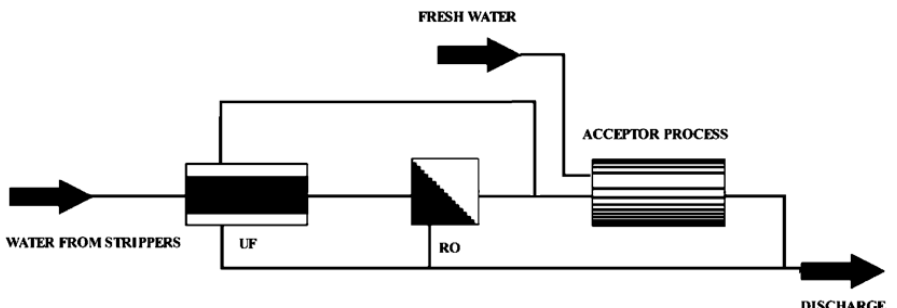
Figure 5. Obtained configuration after the Water-Int simulation.